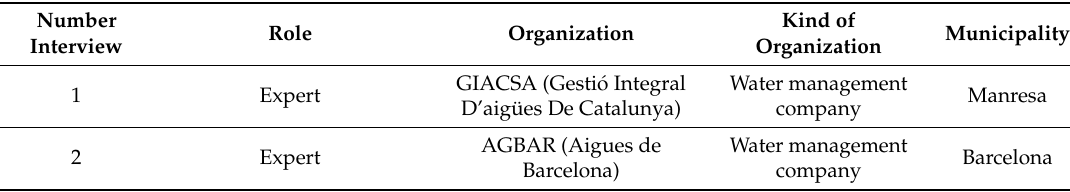
Table A1. List of